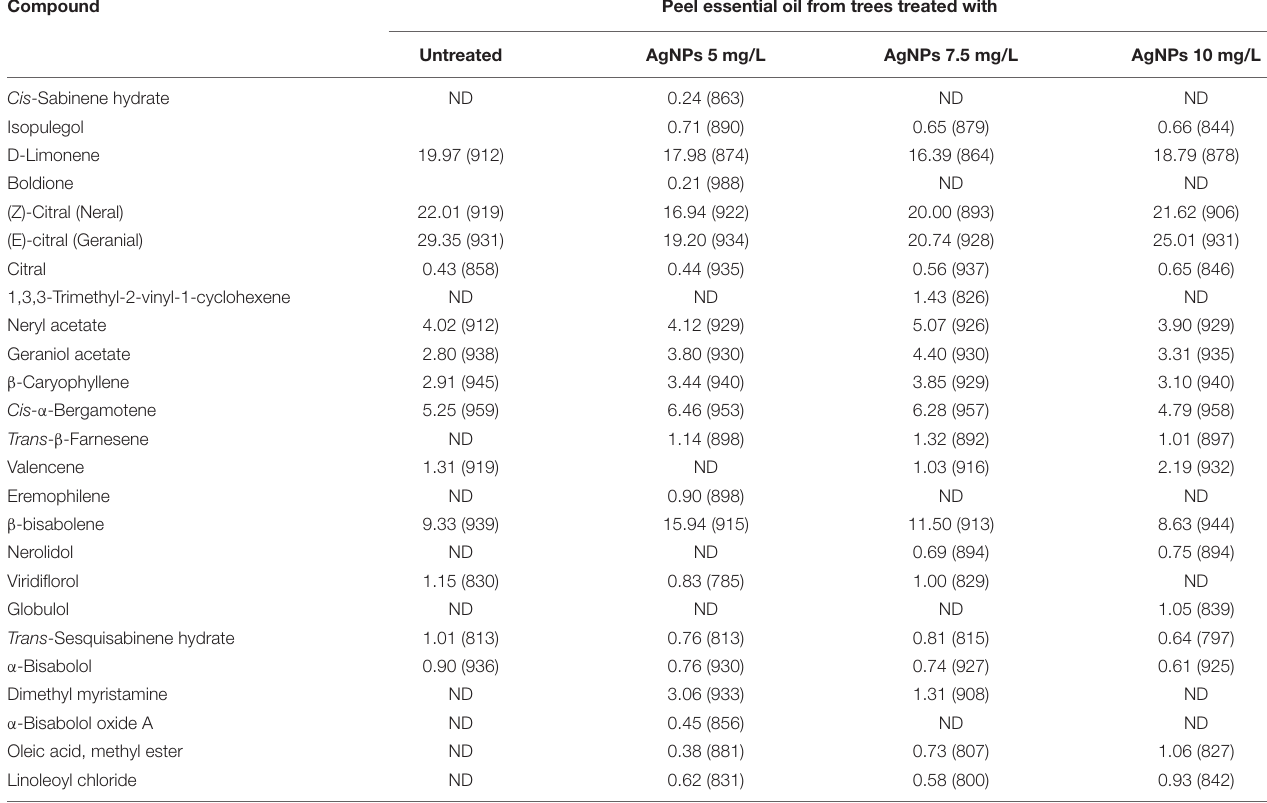
TABLE 8 | Chemical composition of ECo from peels of Citrus limon